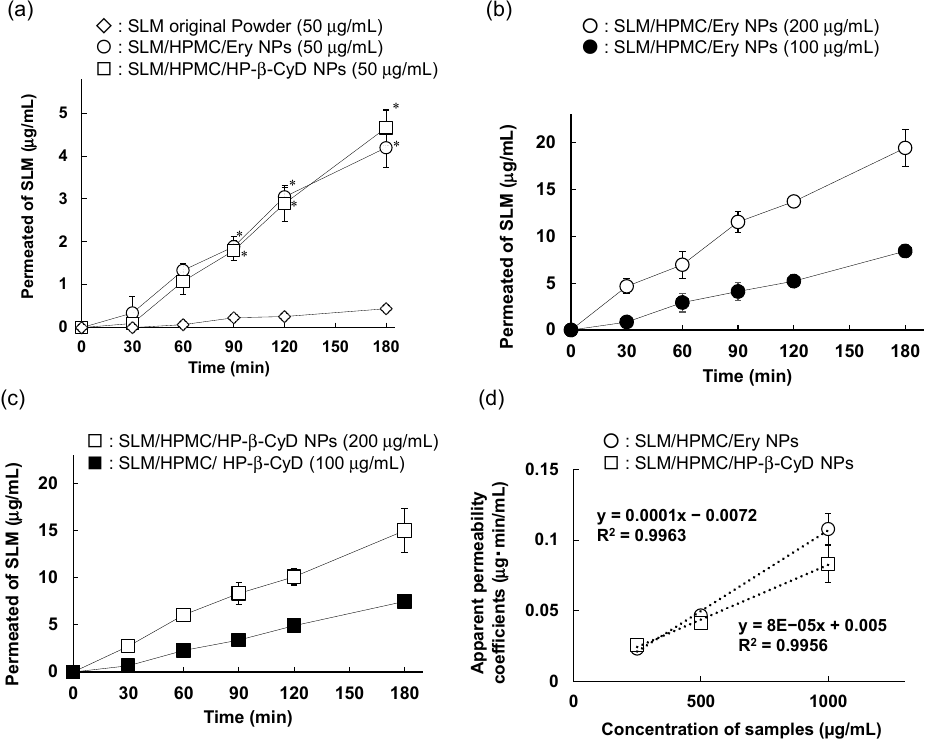
Figure 5. Membrane permeability of silymarin (SLM) original powder, silymarin/hypromellose/erythritol nanoparticles (SLM/HPMC/Ery NPs) and SLM/HPMC/HP- β -CyD NPs against Caco-2 cell monolayers. ( a ) Membrane permeability assay of SLM original powder, SLM/HPMC/Ery NPs or SLM/HPMC/HP- β -CyD NPs at the SLM concentration of 50 mg/mL. * p < 0.05, compared with SLM original powder. ( b , c ) Membrane permeability of SLM/HPMC/Ery NPs and SLM/HPMC/HP- β -CyD NPs at the SLM concentration of 100 mg/mL or 200 mg/mL. ( d ) Correlative evaluation between SLM concentrations of NPs and apparent permeability coefficients. Data represent the mean ± S.E. of 3–4 experiments.